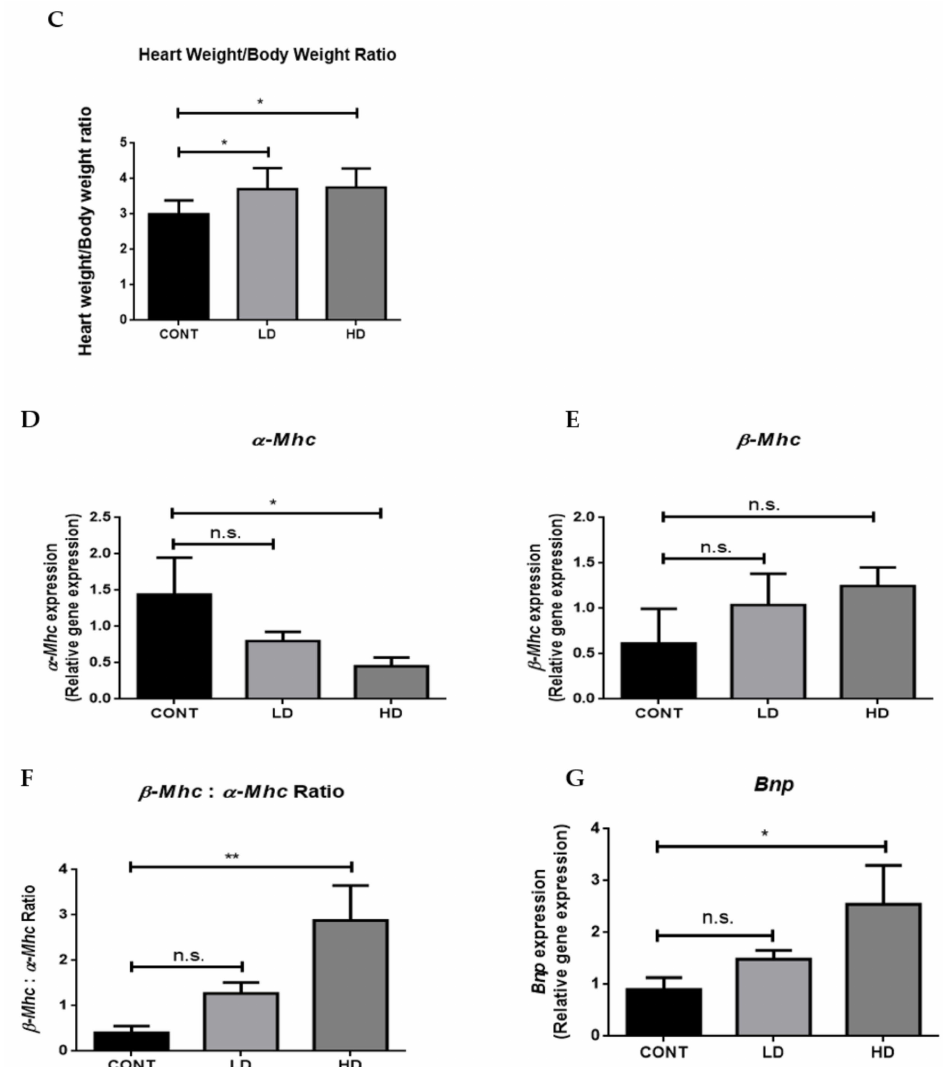
Figure 2. VTX-induced cardiac hypertrophy. ( A ) Body weight; ( B ) heart weight; and ( C ) heart weight to body weight ratio. Data are presented as mean ± SD. * p < 0.05; n.s., no significant changes were observed ( p > 0.05). ( D – G ) mRNA levels of ( D ) α - Mhc , ( E ) β - Mhc , ( F ) β - Mhc to α - Mhc ratio, and ( G ) Bnp were measured using RT-PCR. Data are presented as mean ± SD ( n = 5). * p <